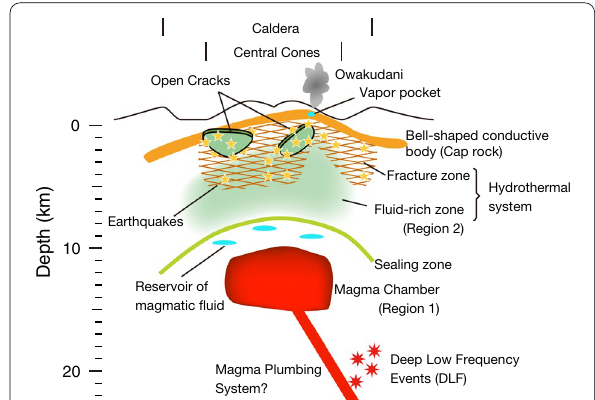
Fig. 2 A schematic model of subsurface structure of Hakone volcano. Diameter of the caldera is approximately 10 km; however, structure beneath the volcano such as magma chamber and open crack are not to scale. This model is a modified version of previous models (Yukutake et al. 2015; Mannen et al. 2018) based on recent studies (Doke et al. 2018; Kobayashi et al. 2018; Yoshimura et al. 2018; Mannen et al. 2019; Ohba et al. 2019; Yukutake et al.